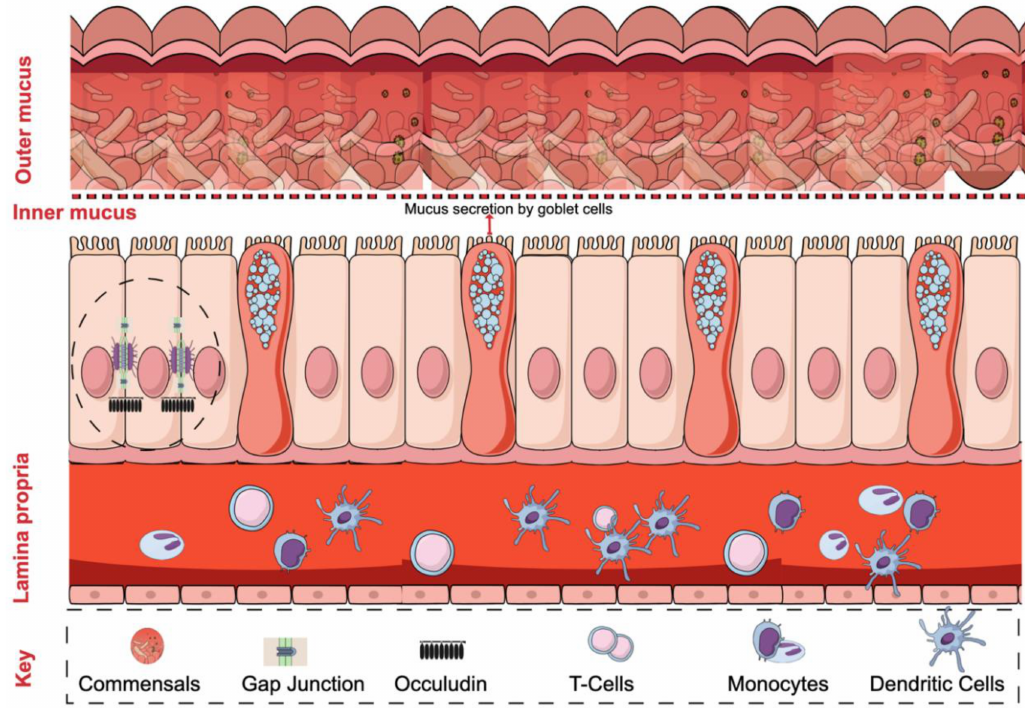
Figure 1. Schematic of the intestinal epithelial barrier. The lining of epithelial cells forms a barrier between the host body and the gut’s lumen with commensal bacteria. The functional barrier cells are held together by many tight junction proteins that hinder the entry of bacteria. The mucosal layer acts as a first-line defense that prevents the contact of gut microbiome with intestinal epithelial cells. The role of immune cells against infection further maintains the hemostasis of the intestinal epithelial